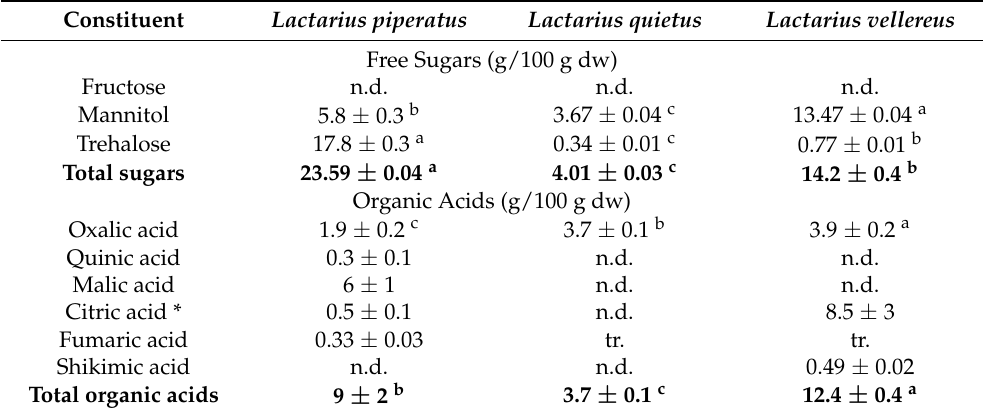
Table 2. Free sugars and organic acids composition of the studied mushrooms (mean ± SD, n = 3).